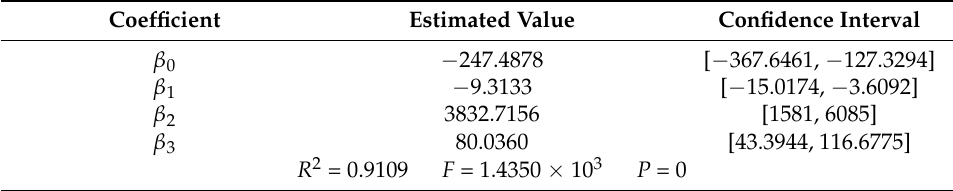
Table 5. Correlation analysis.